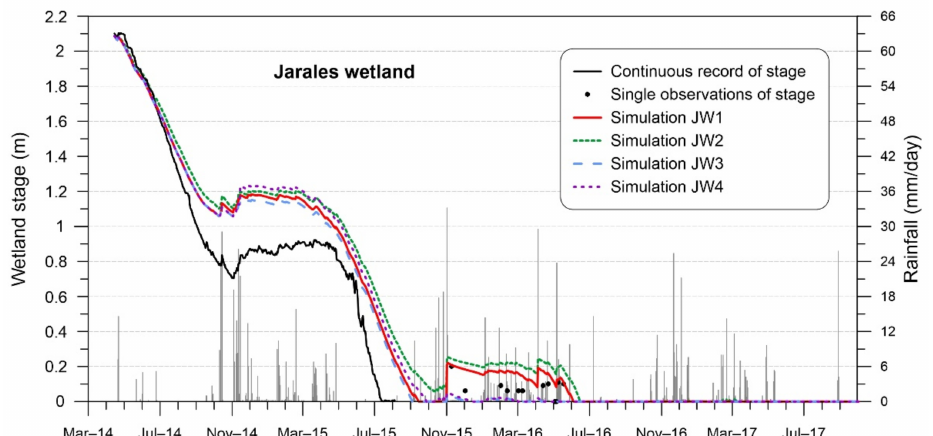
Figure 6. The best four limnimetric simulations of the Jarales wetland (March 2014–September 2017) and the daily wetland stage and rainfall records. JW1, CN runoff with an I a of 19 mm and Penman evaporation; JW2, CN runoff with an I a of 19 mm and Penman–Monteith evaporation; JW3, SWB runoff with Blaney–Criddle ETP, AWC of 100 mm, and Penman evaporation; J4, SWB runoff with Blaney–Criddle ETP, AWC of 75 mm, 50% RC, and Penman